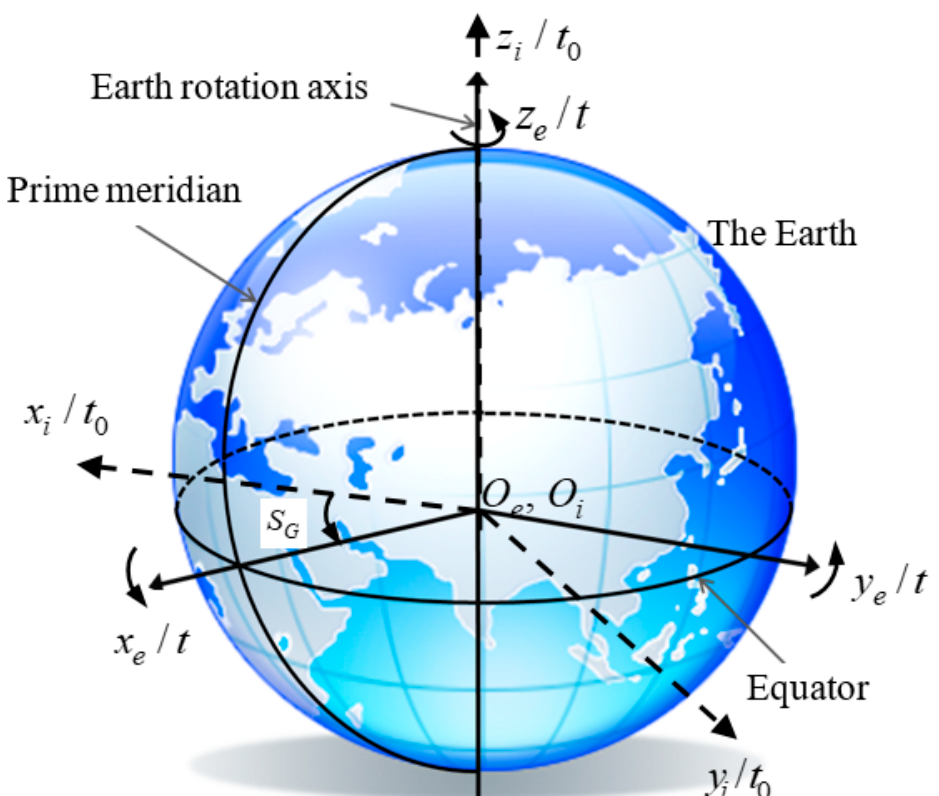
Figure 2. Definitions of spacecraft body coordinate system and space-borne radar measurement coordinate system.